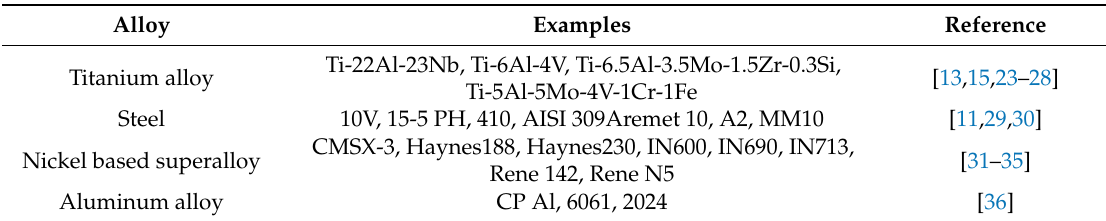
Table 2. Common alloys processed by the DLD